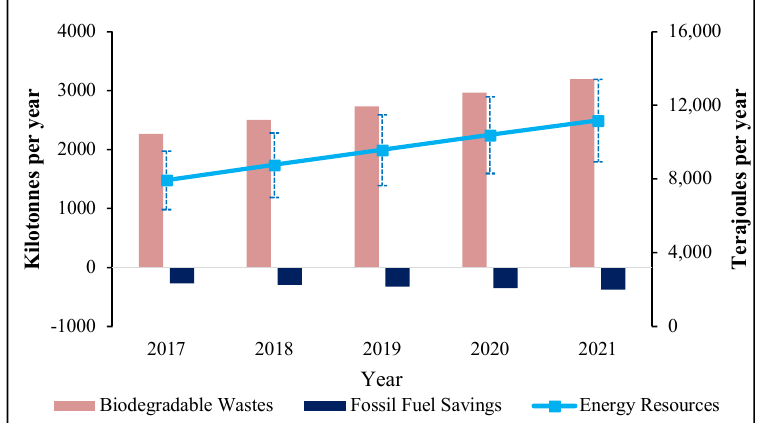
Figure 8. Estimated energy resources from the biodegradable wastes and fossil fuel savings. Standard deviation of the energy resources from the biodegradable wastes is ±20%.